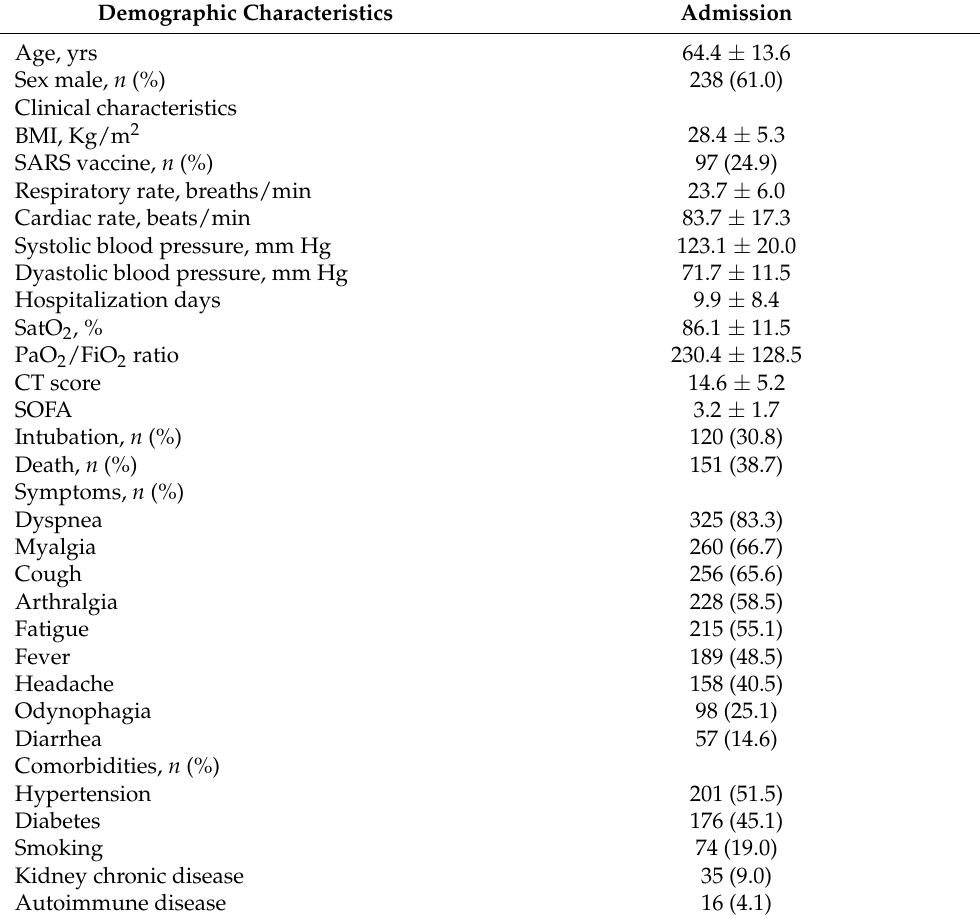
Table 1. Summary of the characteristics of the entire cohort of COVID-19 patients, ( n = 390). Demographic